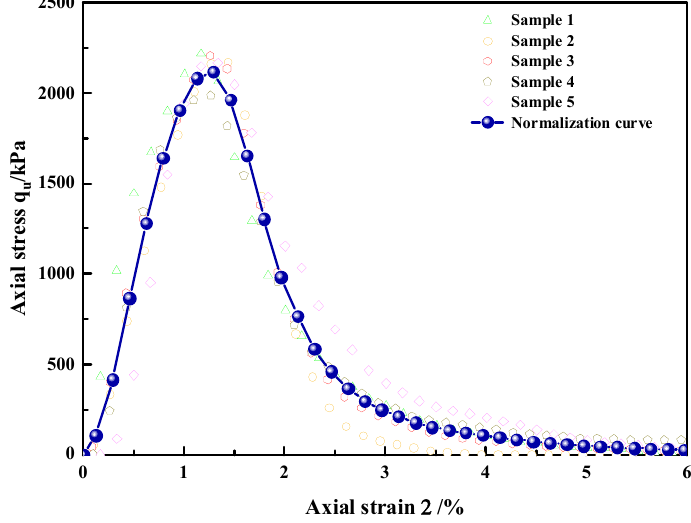
Figure 3. Typical stress–strain normalization curve of RA-10-7d.